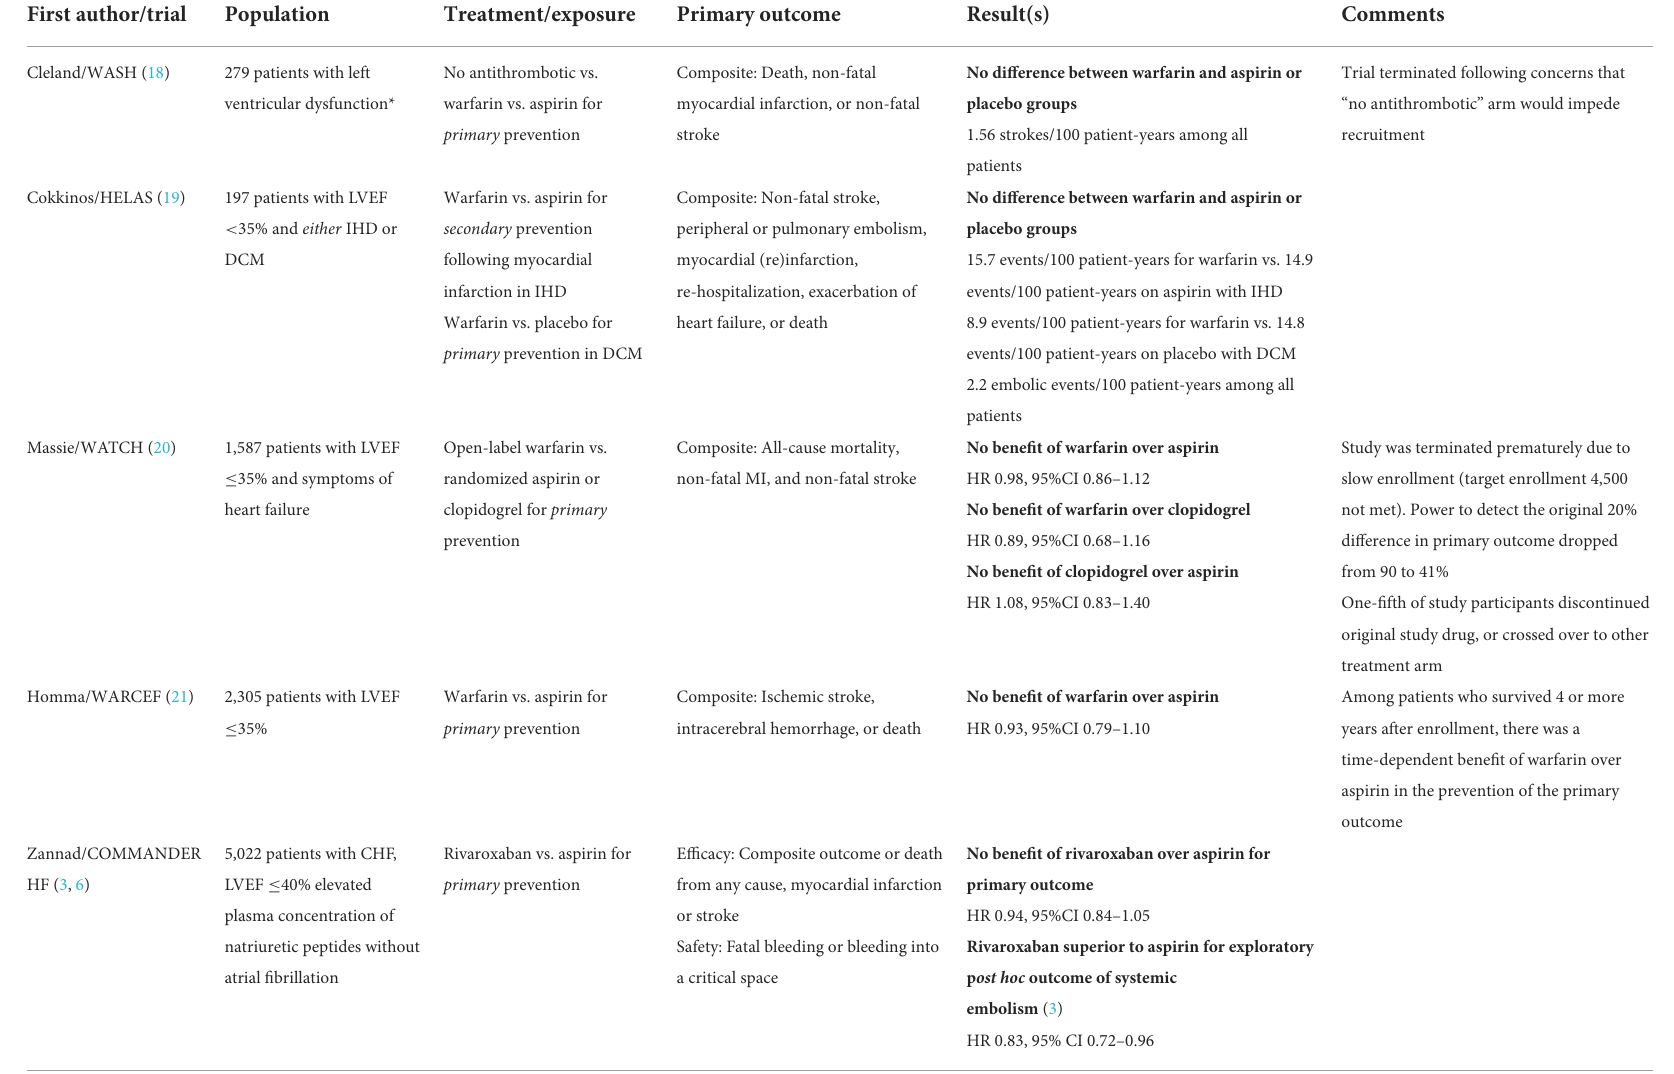
TABLE 3 Summary of published randomized clinical trials evaluating antithrombotic treatment in heart failure with reduced ejection fraction and sinus